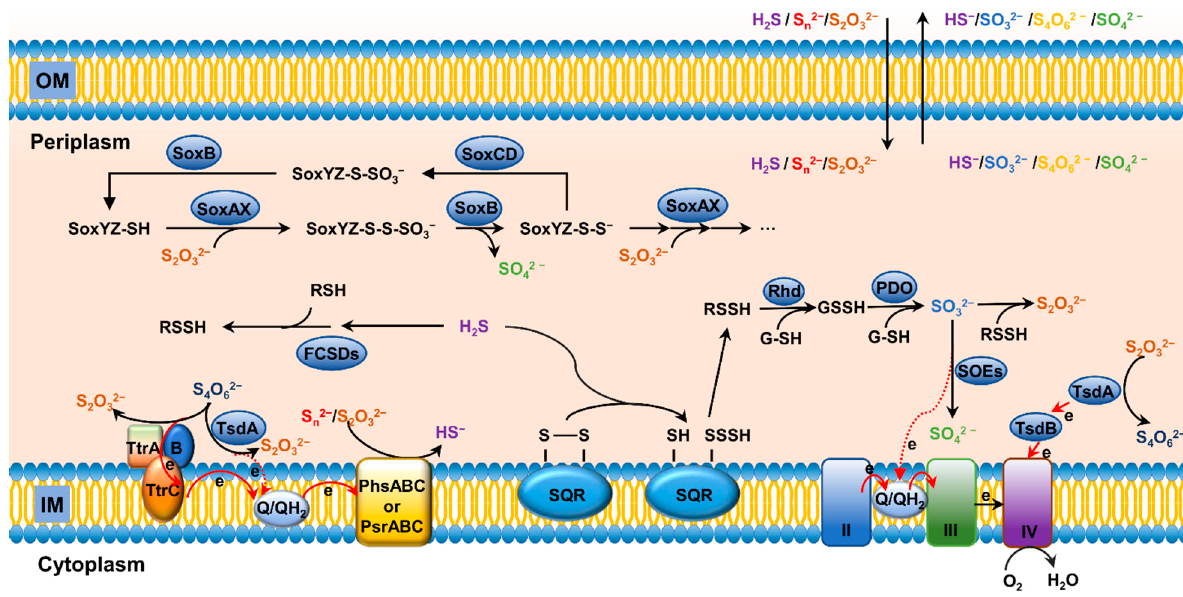
Figure 4. Pathways for bacterial sulfur transformation in the periplasm. Oxidation of S 2 − and S 0 : Flavocyt c sulfide dehydrogenases (FCSDs) can oxidize H 2 S to the final product polysulfide. In dissimilatory sulfur-oxidizing bacteria, Rhds and PDOs are located in the periplasm, and the oxidation of H 2 S is catalyzed by SQRs, which consistently expose the reaction to the periplasm space. Oxidation of S 0 and S 2+ : Unconjugated SoxYZ is catalyzed by SoxAX with S 2 O 32 − , generating SoxYZ-S-S-SO 3 − , which is subsequently converted to SoxYZ-S-S − , releasing one molecular of SO 42 − under the catalysis of SoxB. Reduction of S 2+ : TtrABC and TsdAB are responsible for interconversion of S 4 O 62 − and S 2 O 32 − . Reduction of S 0 : PhsABC and PsrABC are supposed to participate in the reduction of S 0 (S n2 − ) and S 0 (S 2 O 32 − ) to HS −